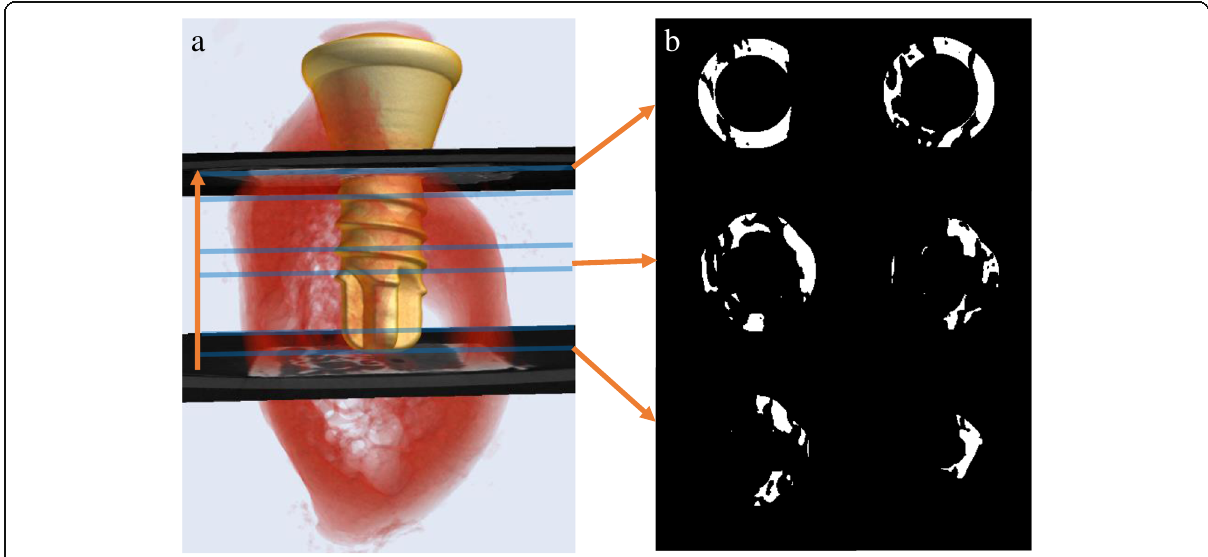
Fig. 1 Automatic micro-CT-based evaluation of bone-to-implant contact (BIC) around the implant. a 3D surface reconstruction indicating the superior (implant shoulder) and inferior (implant apex) limit of volume of interest. b Binary images of BIC surface based on a custom processing with CTAn (version 1.16.1.0, Skyscan1272, Bruker Microct, Kontich, Belgium). Orange arrows indicate the series of slices from the implant apex to the shoulder level. Blue lines indicate the position of the images in b which show the amount of peri-implant bone descends from apex to coronal